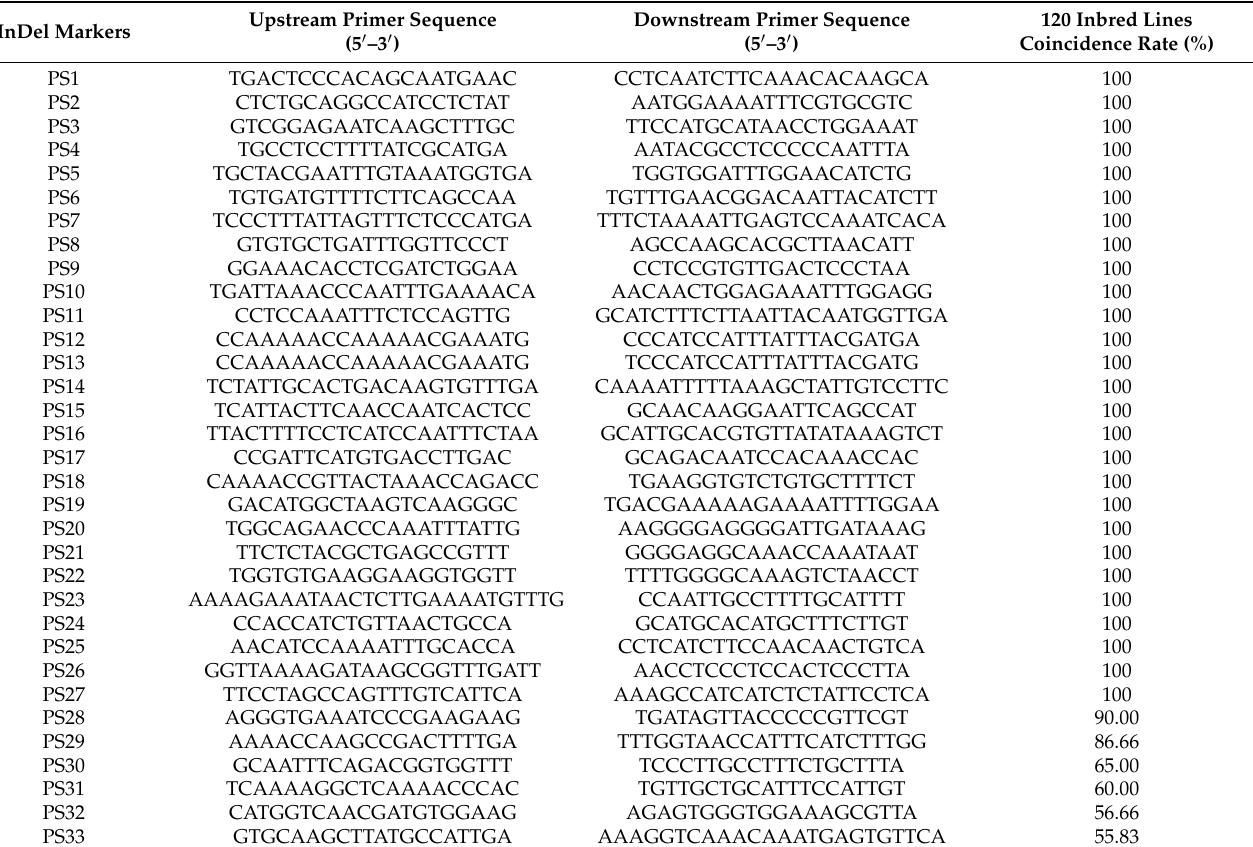
Table 2. Coincidence rate of 33 pairs of peel-colour InDel markers in 120 Inbred lines. InDel Markers